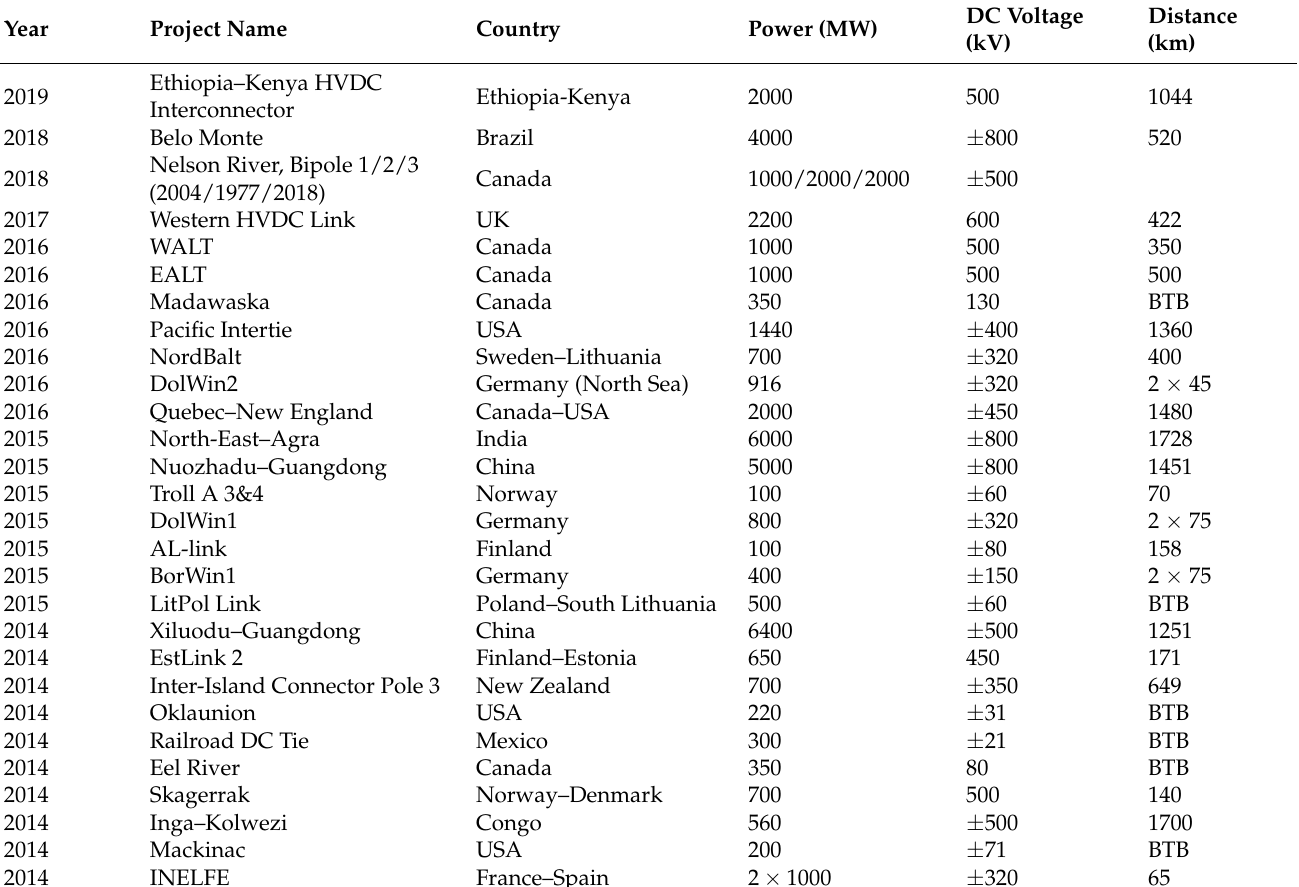
Table 2. Some worldwide LCC-HVDC projects and their basic parameters [56–60].